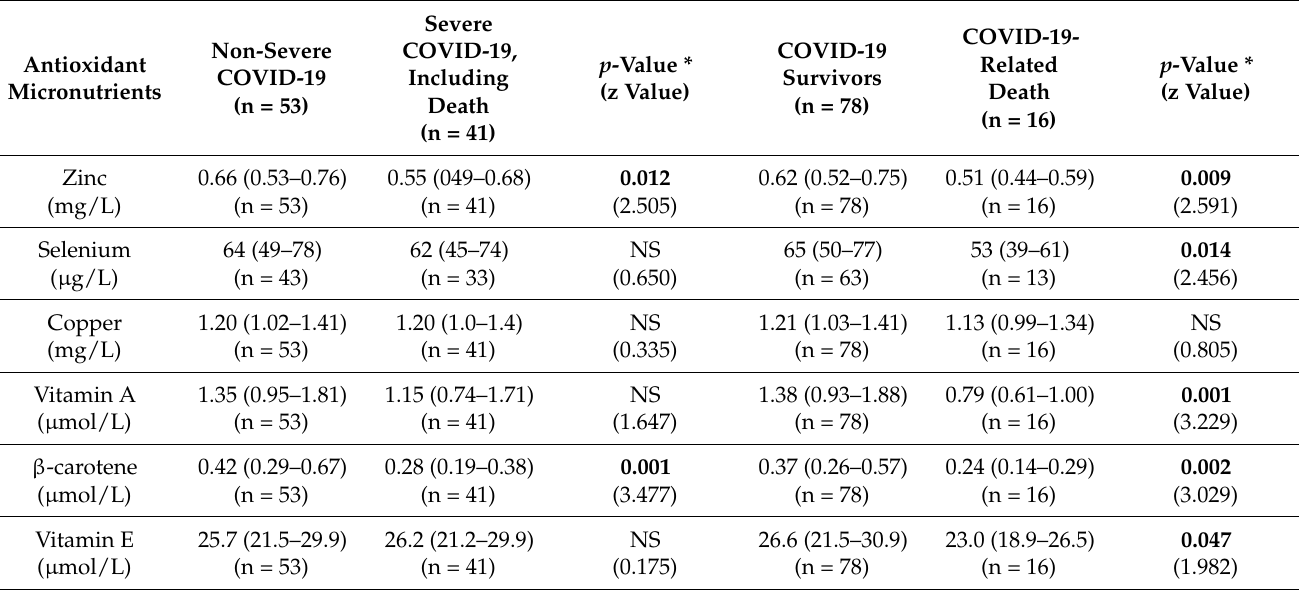
Table 2. Plasma antioxidant micronutrients levels and COVID-19 severity among the 94 patients with micronutrients analysis collected during the first 15 days of